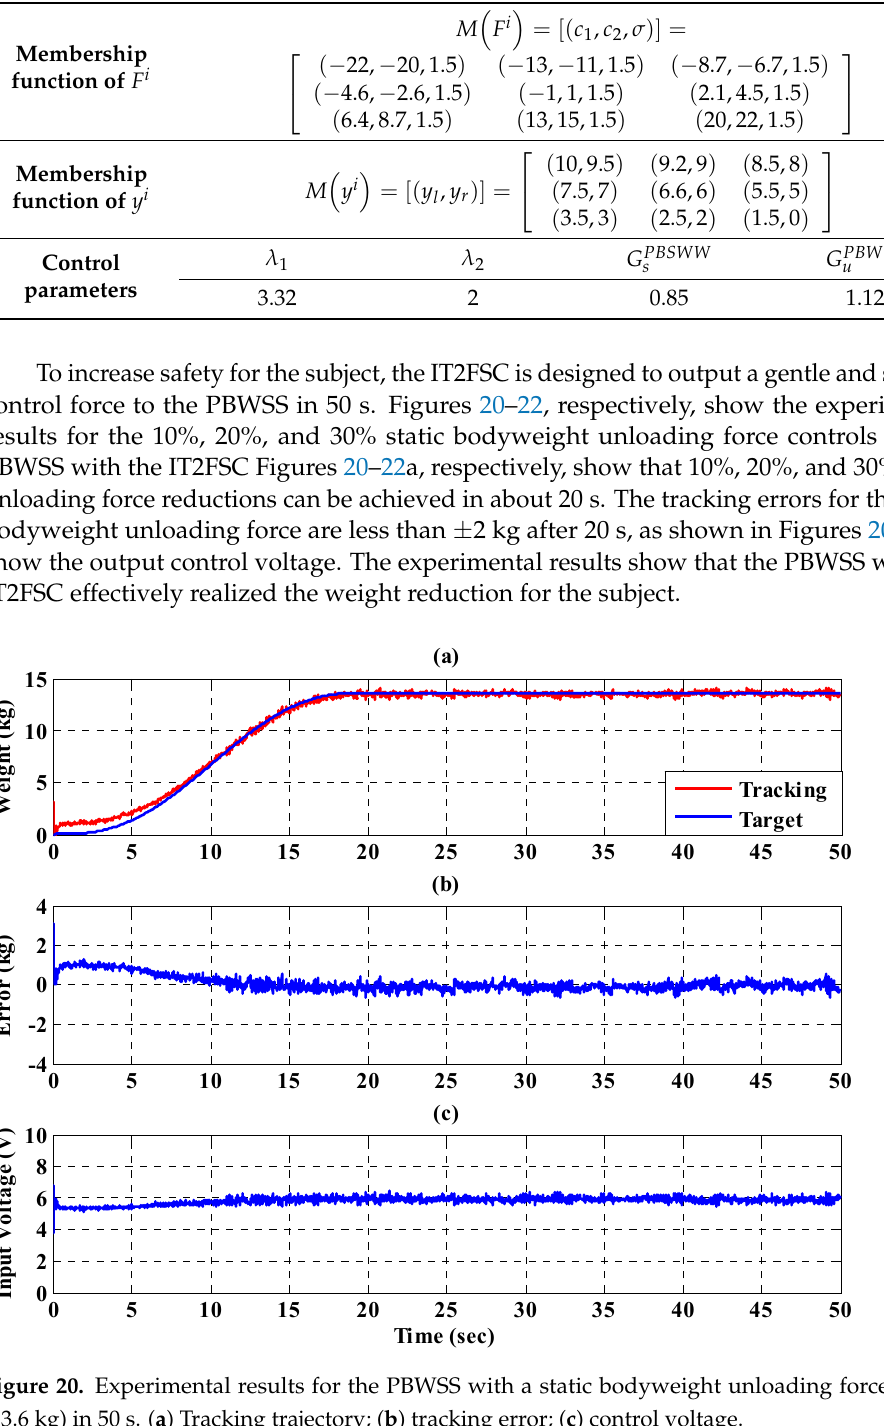
Table 4. The used parameters of the PBWSS with the IT2FSC for the static unloading force control.